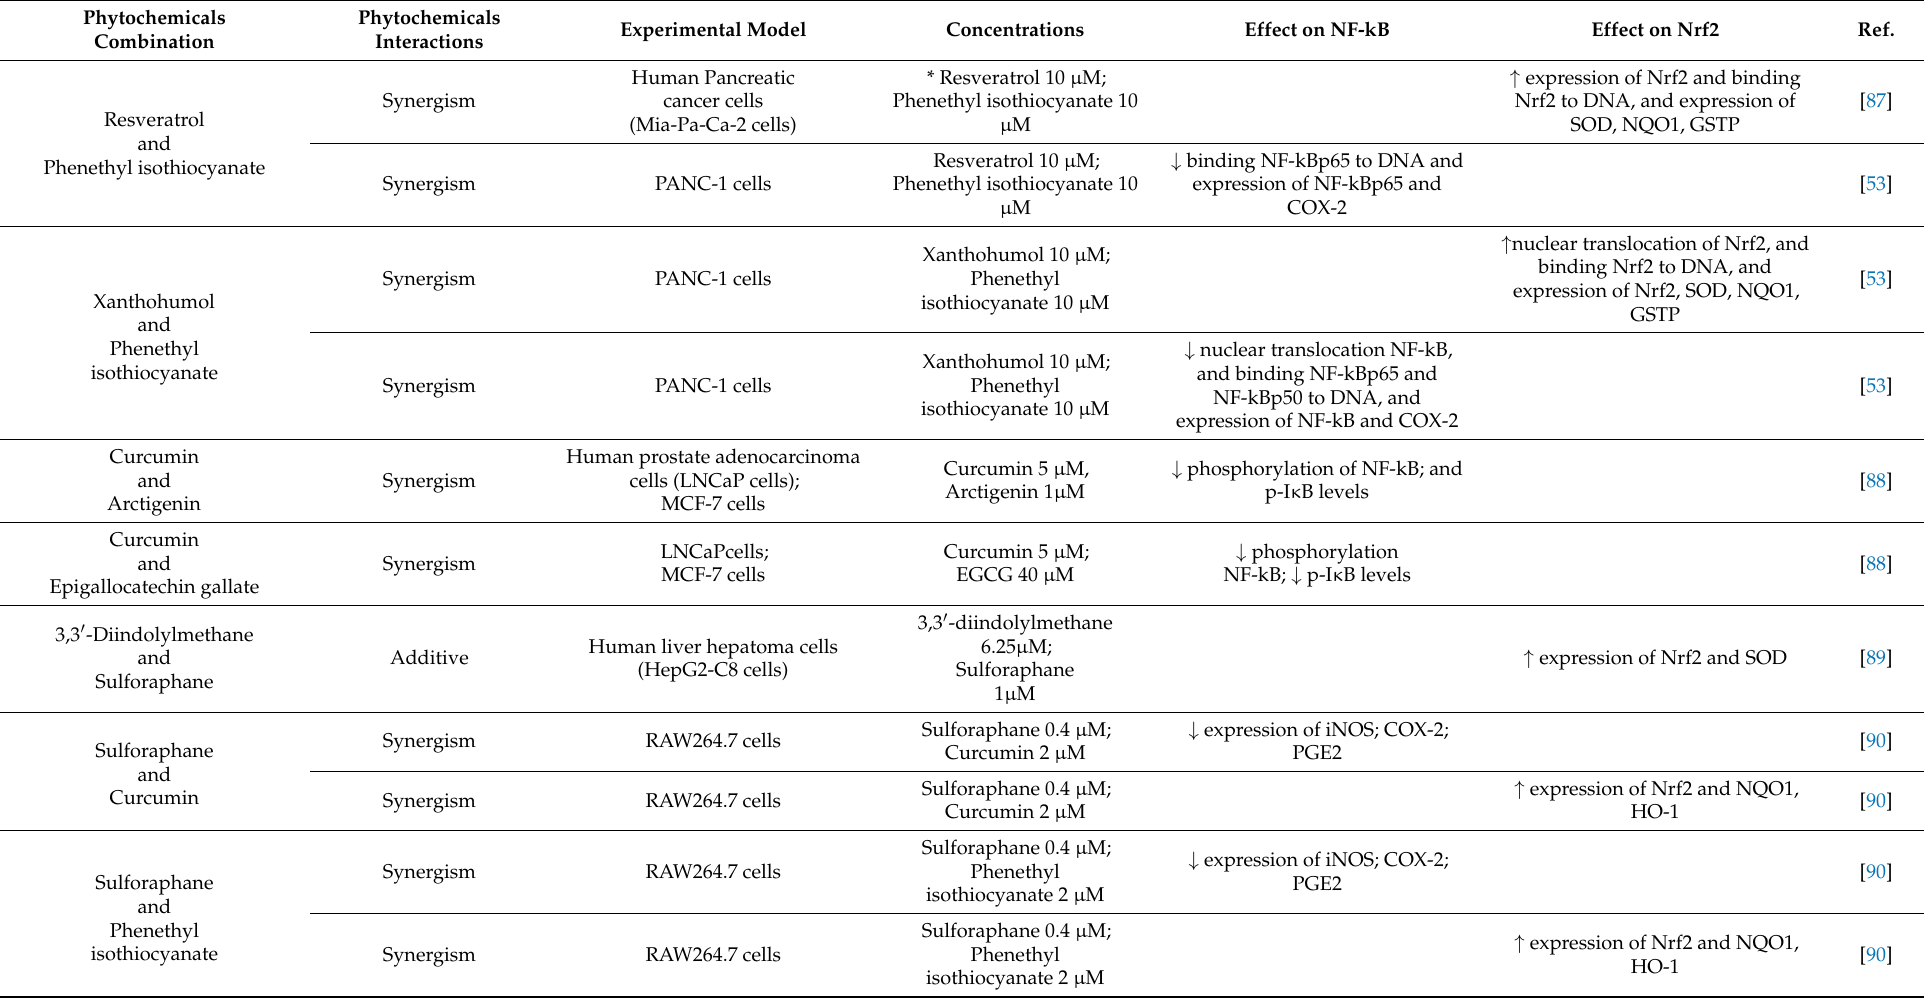
Table 2. Modulation of Nrf2 and NF- κ B pathways by selected combination phytochemicals in vitro and in vivo